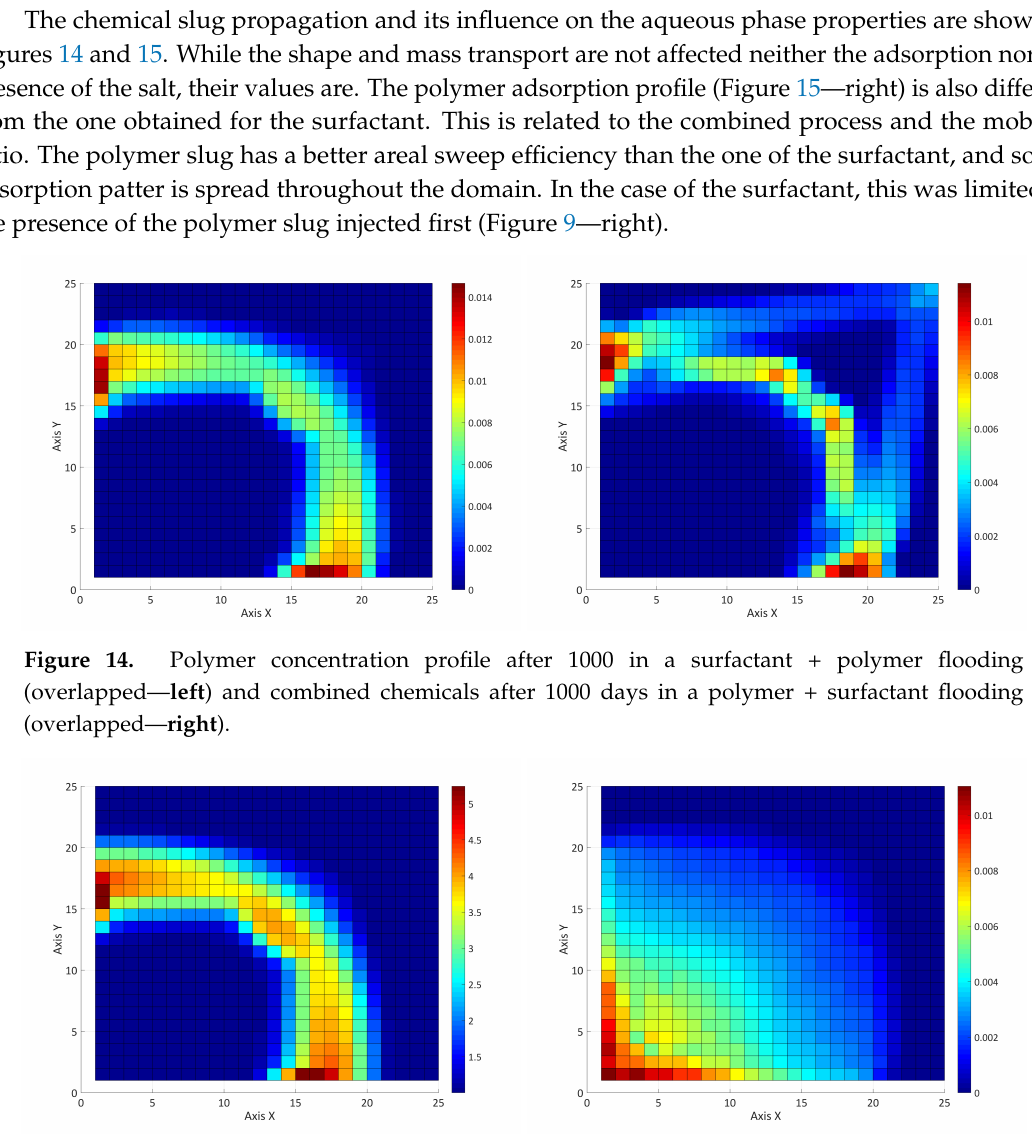
Figure 15. Aqueous phase viscosity [mPa · s] after 1000 days in a surfactant + polymer SP scheme (separated— left ) and amount of polymer adsorbed after 1000 days in a surfactant + polymer flooding (overlapped— right